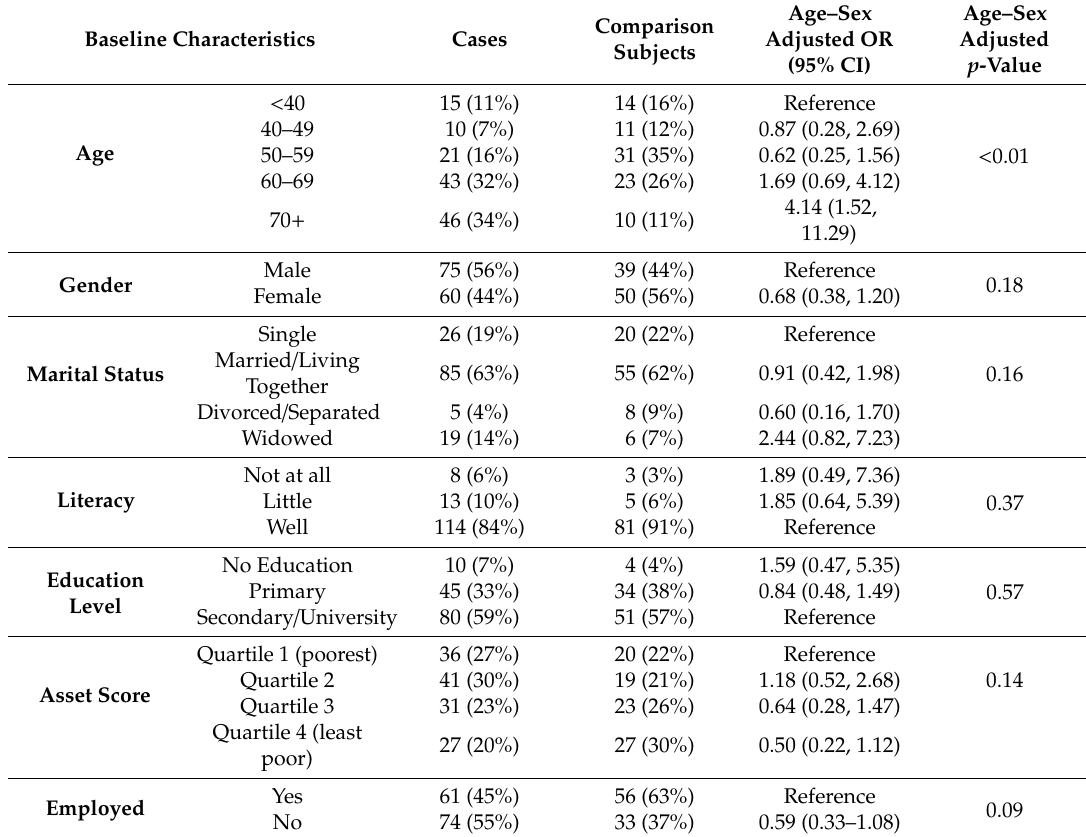
Table 1. Baseline sociodemographic characteristics of cases and comparison subjects.